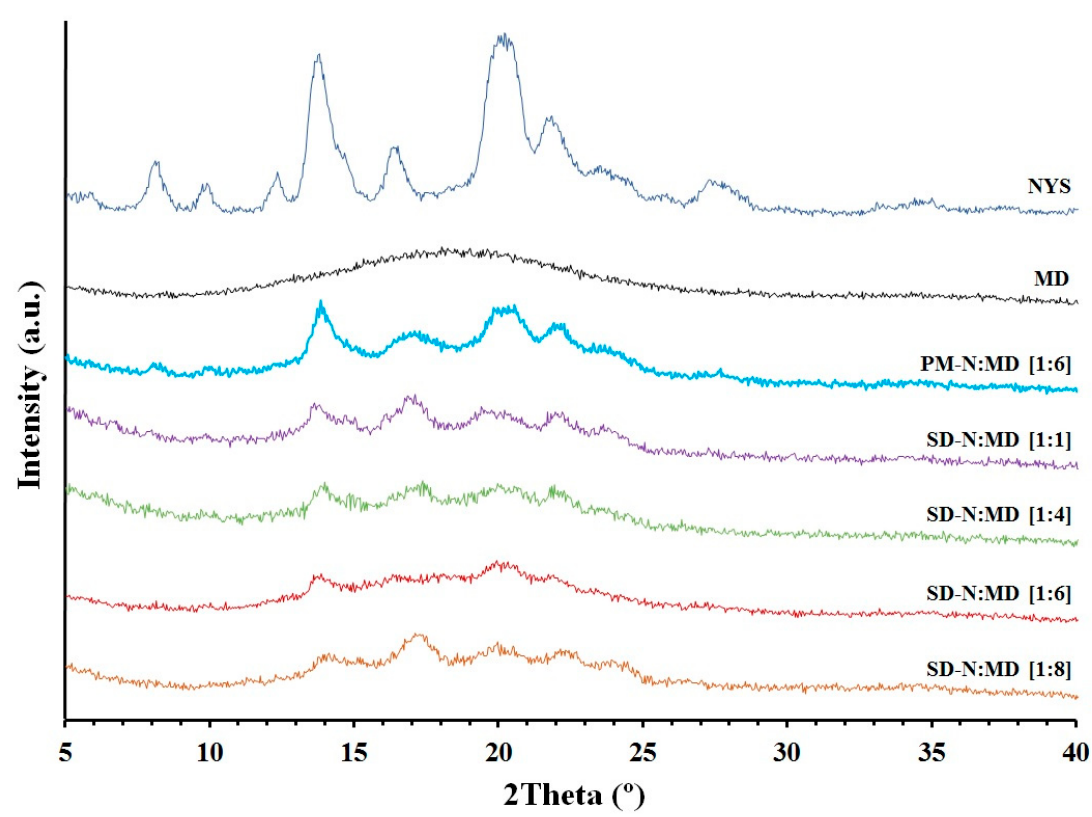
Figure 4. XRPD diffraction patterns of nystatin raw material (NYS), maltodextrin (MD), PM-N:MD [1:6] physical mixture, and SD-N:MD [1:1], SD-N:MD [1:4], SD-N:MD [1:6], and SD-N:MD [1:8] solid dispersions.